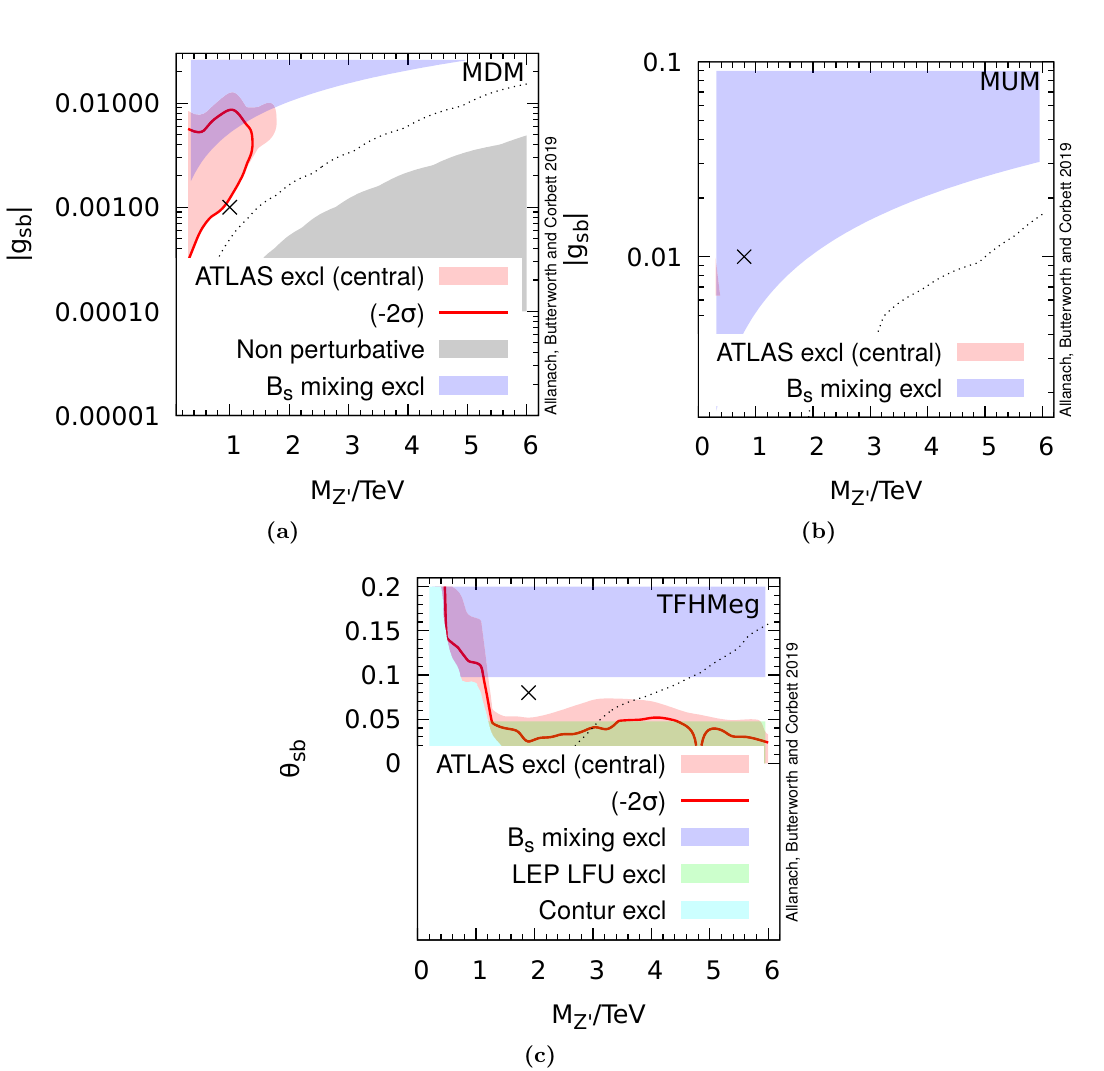
Figure 4 . Collider constraints on the central fits of the models to NCBAs for (a) the MDM model, (b) the MUM model and (c) the TFHMeg. The allowed region is shown in white. Everywhere throughout the parameter plane shown, the third parameter is fixed by the central fit to the NCBAs: g µµ as in eq. (2.2) in (a) and (b), and g F as in eq. (2.16) in (c), each with x = 1 . 06. The 1, whereas the dotted lines display where region marked ‘non-perturbative’ in (a) has Γ Z (cid:31) /M Z (cid:31) > = 0 . 1 for each model (this quantity increases toward the right-hand side of each plot). Γ Z (cid:31) /M Z (cid:31) mixing constraint from eq. (2.6) excludes the ‘ B mixing excl’ region. In (c), the region The B s s excluded by the LEP lepton flavour universality is shown by the legend as ‘LEP LFU excl’ and is 1 di-muon Z calculated in ref. [61]. The ATLAS 139 fb exclusion region is marked ‘ATLAS excl − (cid:30) (central)’ in each plot. Varying the NCBA fit to be 2 σ toward the SM limit results in the smaller ‘( 2 σ )’ exclusion region. The dark crosses show the locations of the example points listed in table 1. − In (c), we also display the region excluded by Contur at the 95% CL s